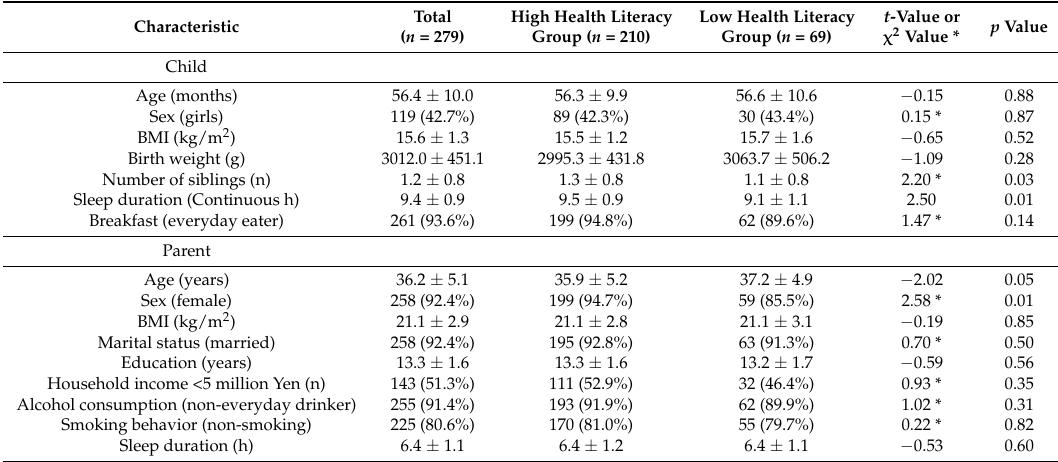
Table 2. Characteristics Differences between the High Health Literacy and Low Health Literacy